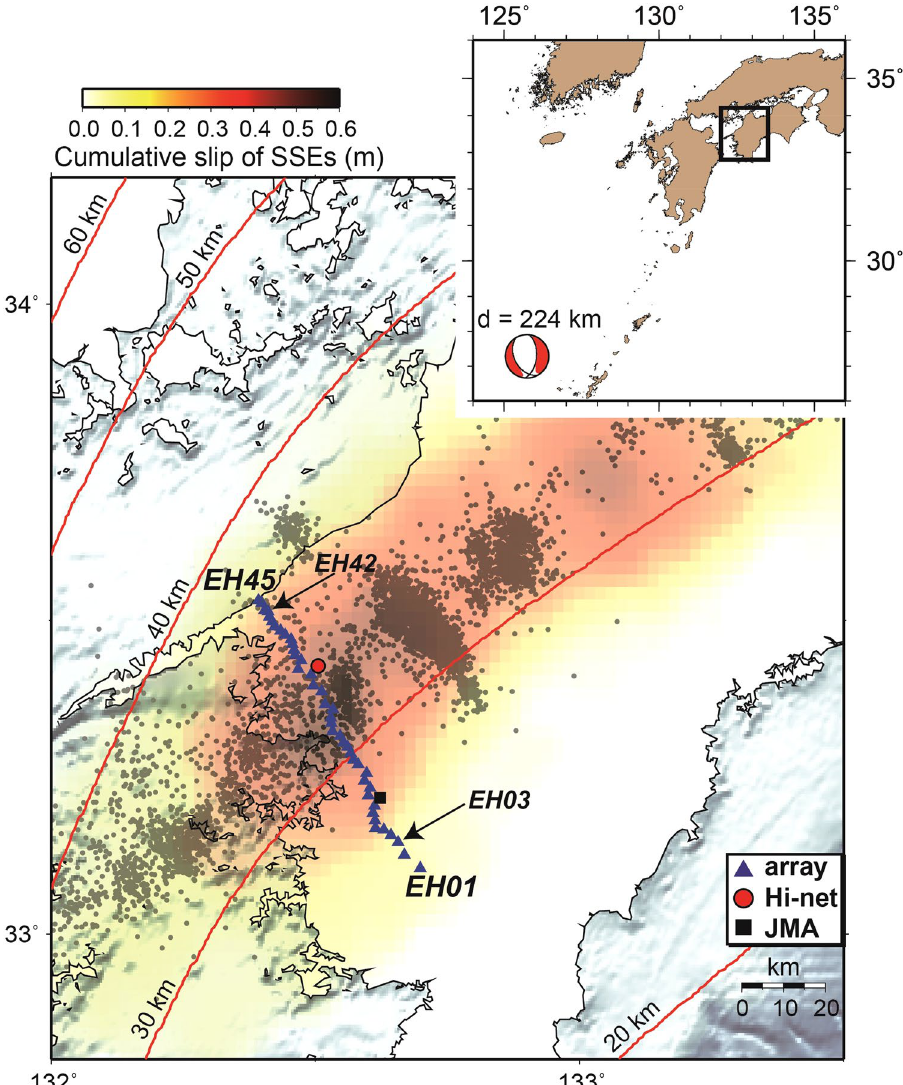
Figure 1. Seismotectonic setting of western Shikoku, Japan, and location of the linear seismic array used in this study. Blue symbols denote portable instruments (triangles), Hi-net station (circle), and JMA station (square). Background color scale represents the total cumulative slip of slow slip events (SSEs) between June 1996 and January 2012 14 . Gray dots are epicenters of low-frequency earthquake (LFE) determined by JMA. Red curves denote iso-depth contours of the subducting Philippine Sea Plate in the JIVSM model 20 . The inset shows the location of the study area and a large deep event analyzed in this study, along with a moment tensor (determined by F-net, NIED, Japan). Map was created using the GMT (Generic Mapping Tools, http://gmt.soest.hawaii.edu/) software package 37